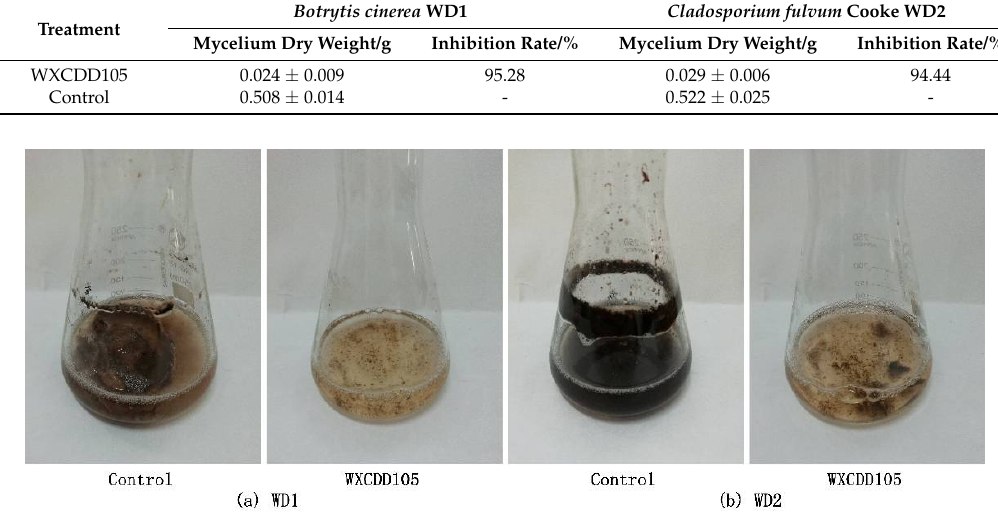
Figure 4. Inhibitory effects of sterile filtrate of strain WXCDD105 on mycelial growth of Botrytis cinerea WD1 ( a ) and Cladosporium fulvum Cooke WD2 ( b ). WD1 ( a ) and Cladosporium fulvum Cooke WD2 ( b